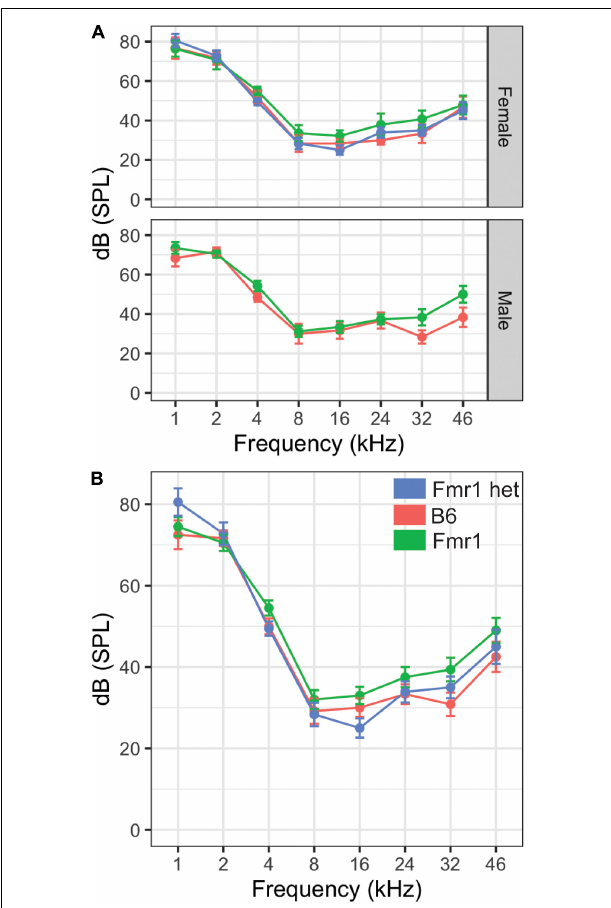
FIGURE 3 | Hearing threshold (dB SPL) was measured across frequencies (1–46 kHz) in male and female mice of all genotypes (A) . There were no differences in the hearing range between Fmr1 (green), B6 (red), and Fmr1 het (blue) mice of either sex (top panel A ). When sexes were combined, there was no significant difference in hearing across frequencies (B) . Data represent 6 B6, 7 Fmr1, 9 Fmr1 het females and 6 B6, 11 Fmr1